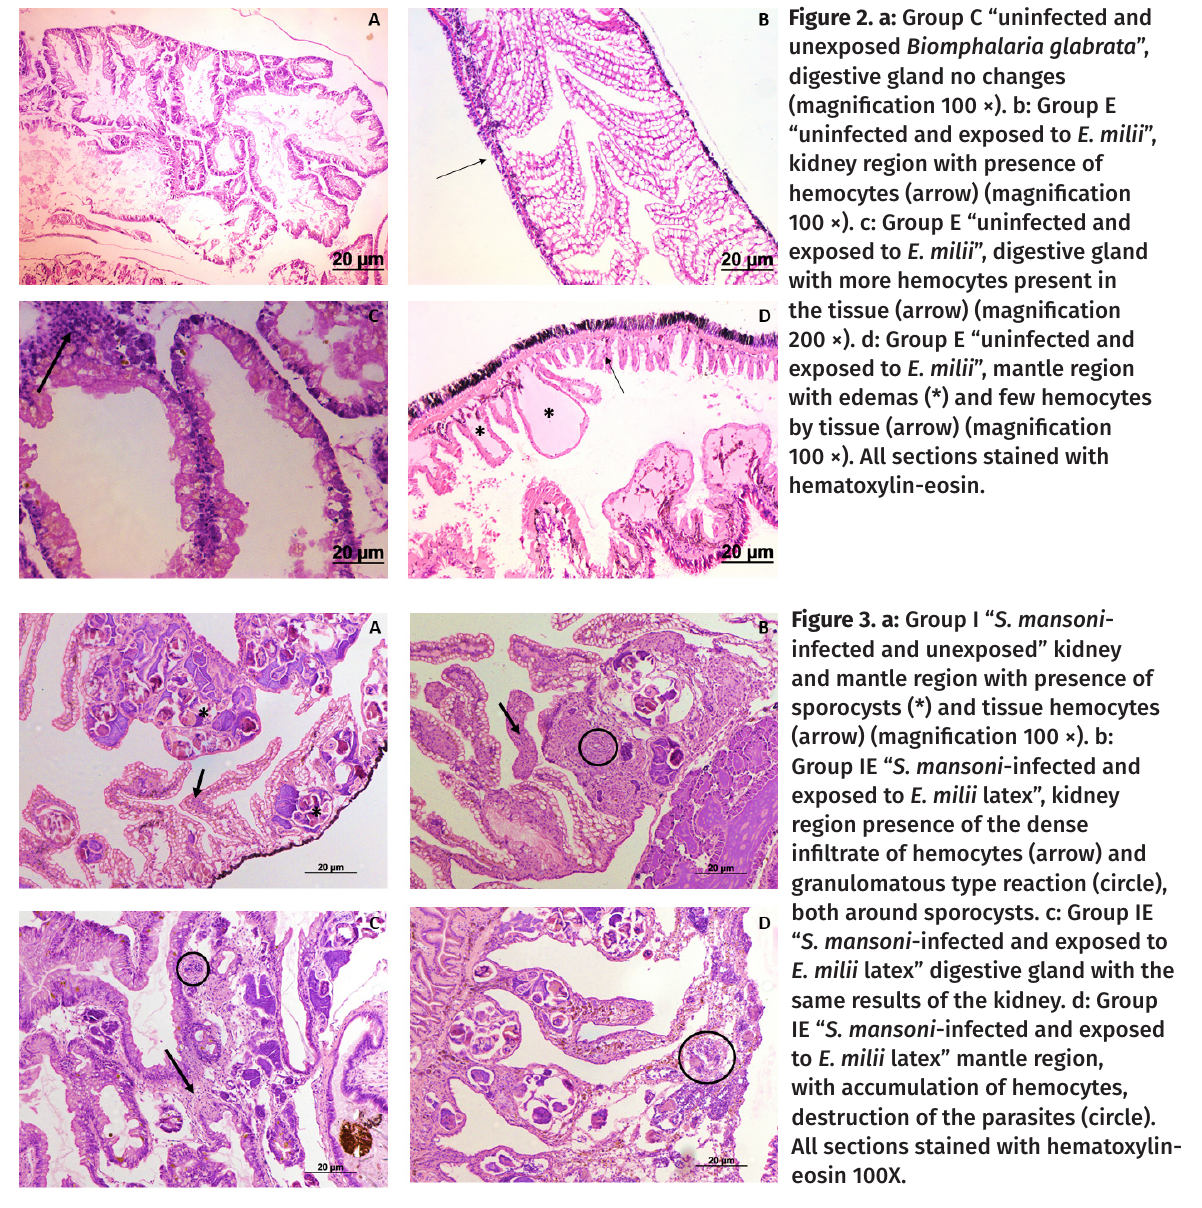
Figure 2. a: Group C “uninfected and unexposed Biomphalaria glabrata ”, digestive gland no changes (magnification 100 ×). b: Group E “uninfected and exposed to E. milii ”, kidney region with presence of hemocytes (arrow) (magnification 100 ×). c: Group E “uninfected and exposed to E. milii ”, digestive gland with more hemocytes present in the tissue (arrow) (magnification 200 ×). d: Group E “uninfected and exposed to E. milii ”, mantle region with edemas (*) and few hemocytes by tissue (arrow) (magnification 100 ×). All sections stained with hematoxylin-eosin.